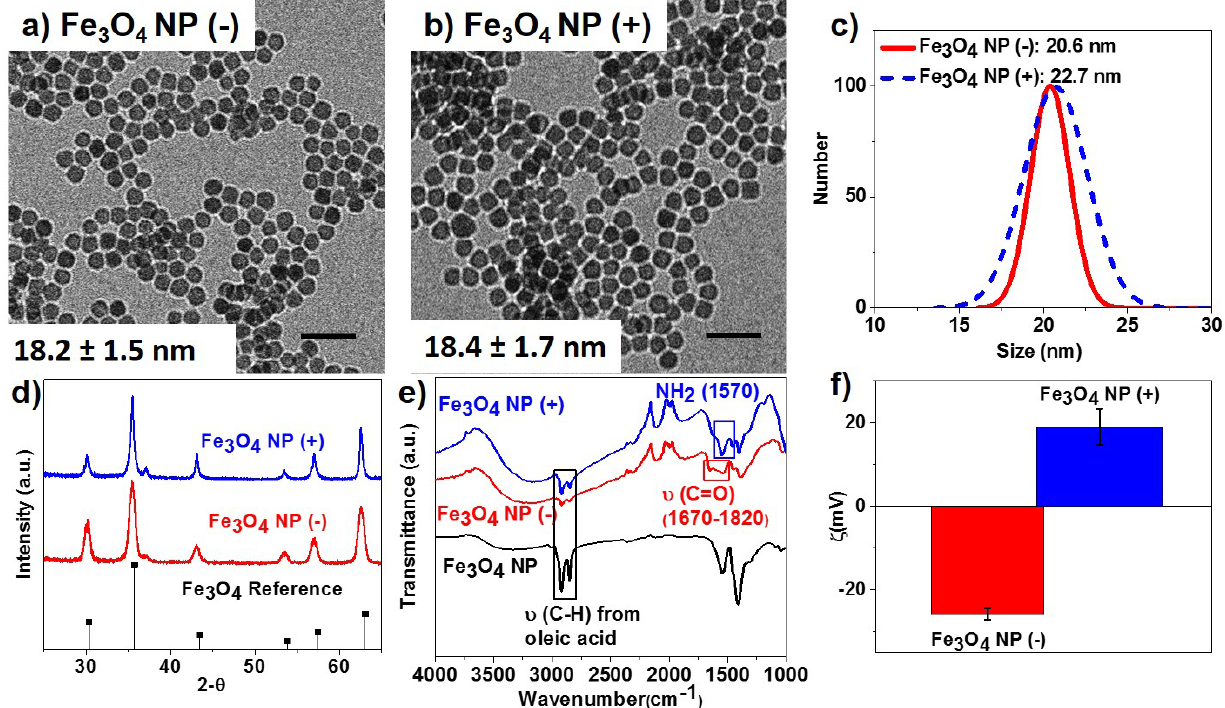
Figure 1. ( a , b ) Transmission electron micrographs of magnetite nanoparticles (NPs) (Fe 3 O 4 ) functionalized with COOH (−) and NH 2 (+) groups, respectively. Scale bars are 50 nm; ( c ) Dynamic light scattering measurements; ( d ) powder X-ray diffraction patterns; ( e ) Fourier transform infrared (FTIR) spectra; and ( f ) zeta potential measurements of the synthesized Fe 3 O 4 NP (−) and Fe 3 O 4 NP (+) samples,